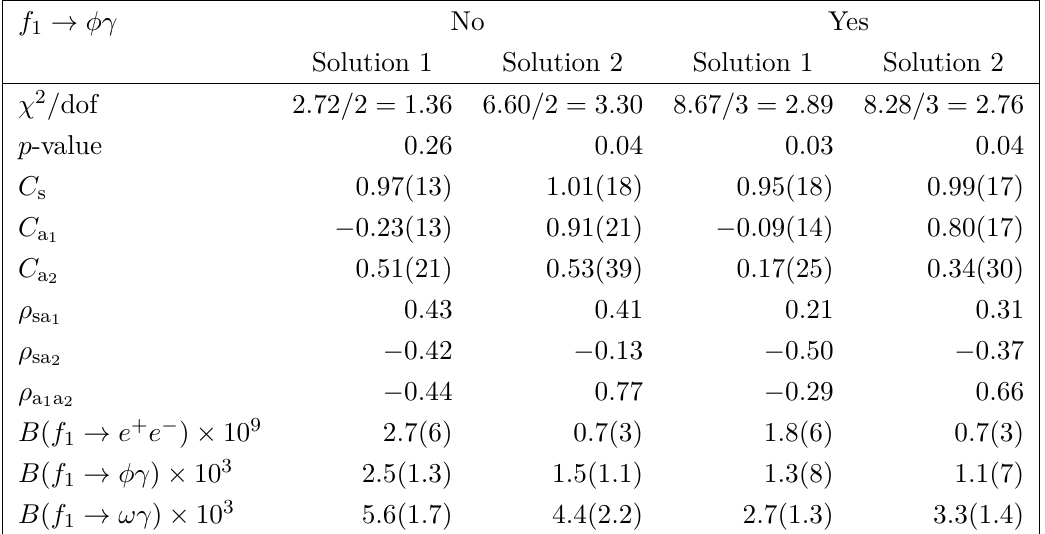
Table 8 . Best-fit results for the three VMD couplings C s , C a , and C a in the minimal VMD 1 2 representation. Each fit includes the constraints from the normalization and slope of the TFF measured by L3 in e + e − → e + e − f 1 , from B ( f 1 → ργ ) , r ργ , and B ( f 1 → e + e − ) . In addition, we show the variants including B ( f 1 → φγ ) as a sixth constraint assuming U (3) symmetry. The p uncertainties include the scale factor S = χ 2 / dof. We also show the correlations ρ ij among the three couplings and the value of B ( f 1 → e + e − ) preferred by each fit. Since the experimental uncertainties dominate by far in the case of B ( f 1 → e + e − ) , we only show the results for Γ ( ωπ,ππ ) ( y ) ρ 0 √ and s m = 1 . 3 GeV and do not include the theory uncertainties discussed in detail in section 5. The uncertainties quoted for B ( f 1 → V γ ) refer to the fit errors and R V , but do not include any U (3)